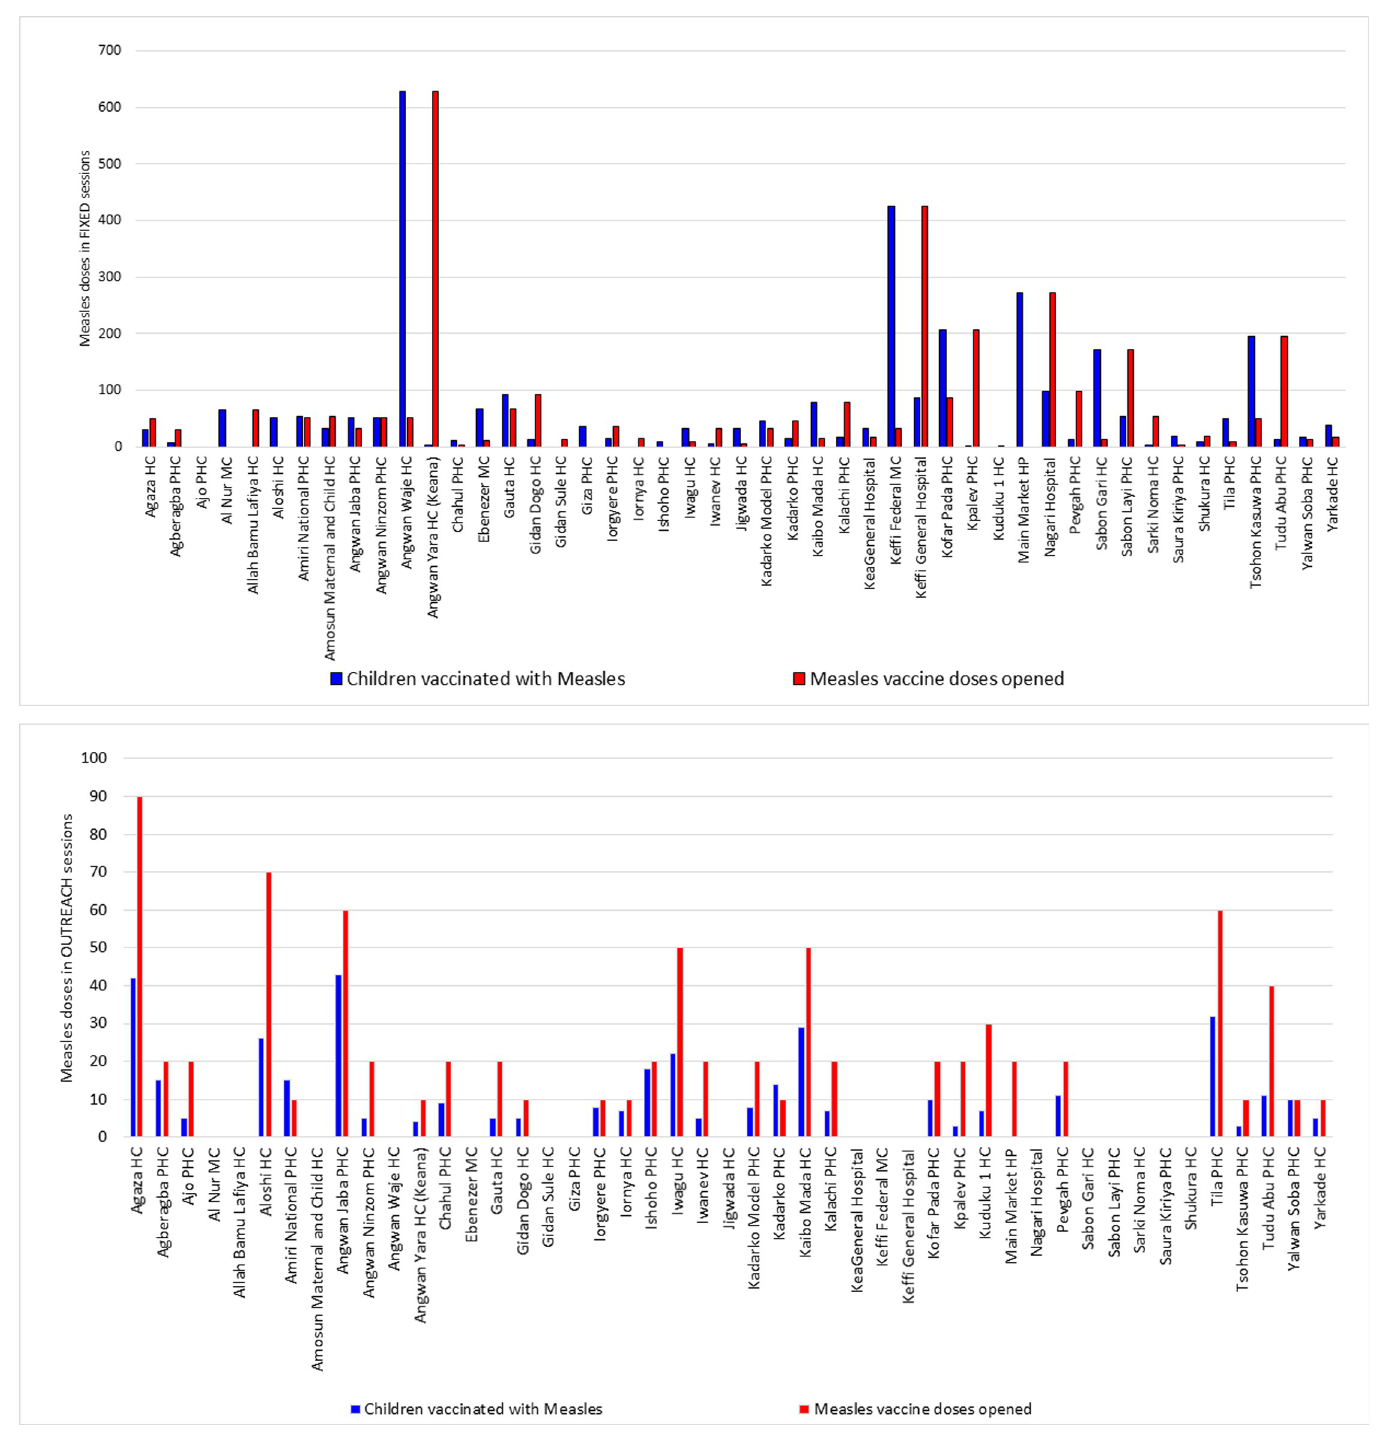
Fig 8. a. Number of children vaccinated with Measles vs. number of measles vaccine doses opened during the pilot, as part of fixed-post vaccination sessions. b. Number of children vaccinated with Measles vs. number of measles vaccine doses opened during the pilot, as part of outreach vaccination